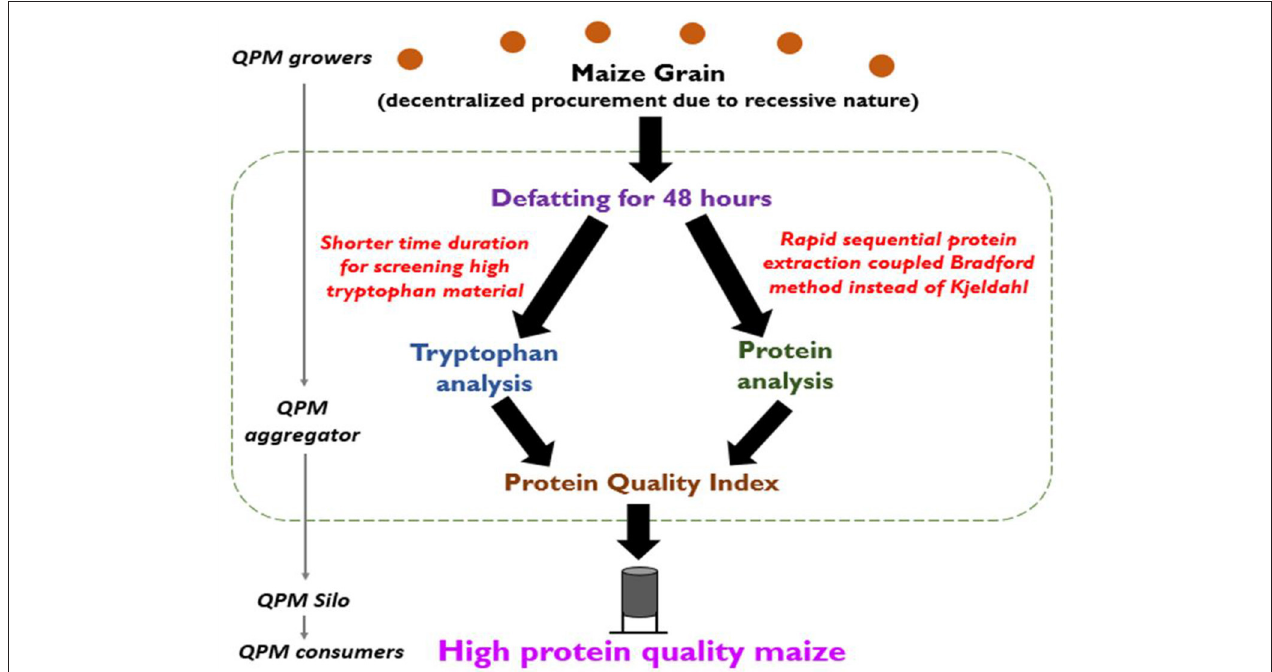
FIGURE 7 | Workflow to screen high-protein-quality maize for aggregation of QPM material. Shorter duration of defatting for tryptophan estimation coupled with the use of defatted maize for protein estimation by the modified Bradford method would enable the resource-poor laboratories to screen QPM and extend the technology for societal